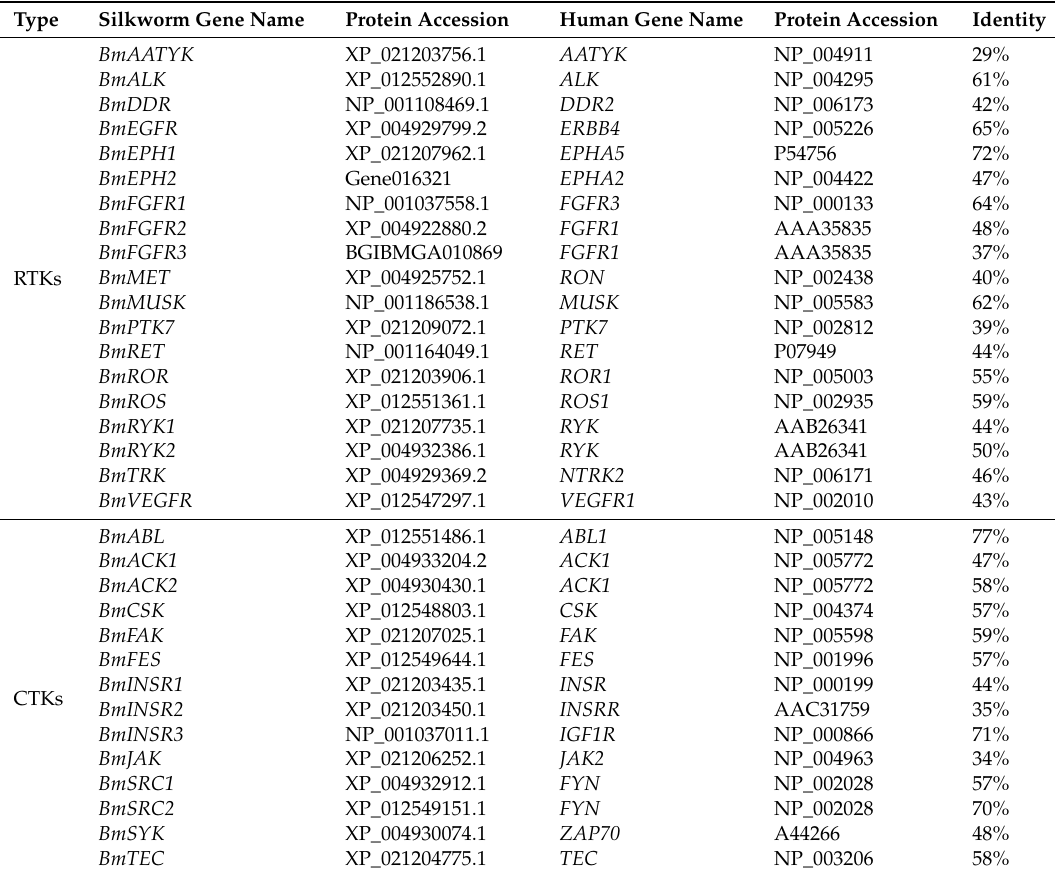
Table 2. Orthology of silkworm and human TKs with names, protein accession numbers, and sequence identity of kinase